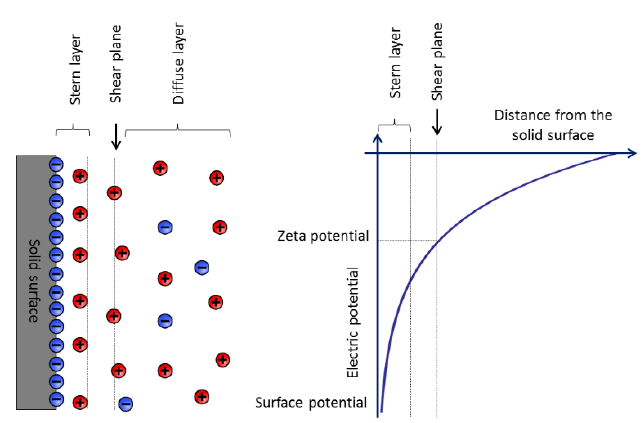
Figure 1: Stern model for the charge and electric potential distribution in the EDL at a solid-liquid interface (Thanh et al., 2015; Thanh et al., 2019). In Vietnam, there are thousands of lakes and dams with the presence of 13.200 of kilometers of dikes (Hung et al., 2014). Most of them are